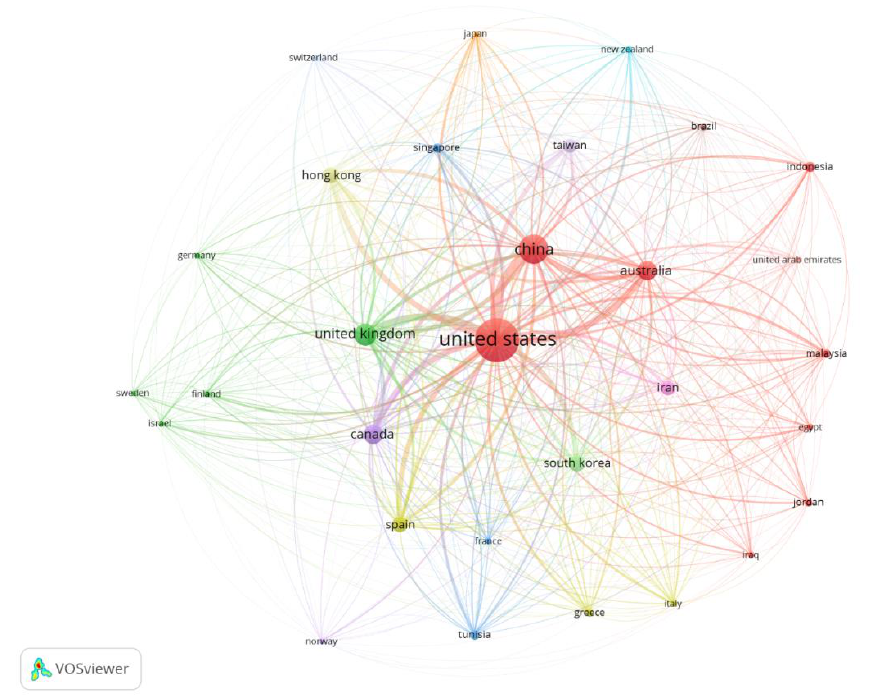
Figure 2. BC of countries.